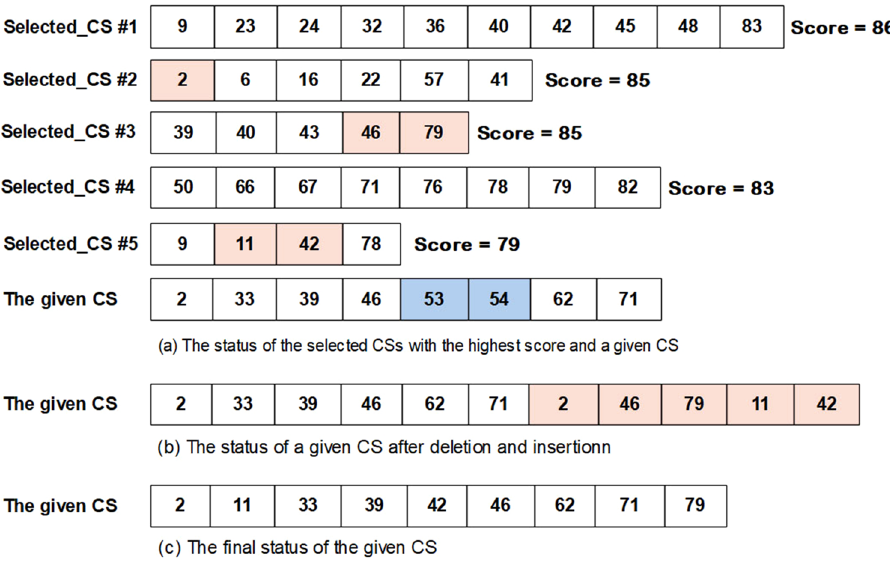
Figure 7. An instance of the transferring operator. The arrays present CSs which include a set of different features. ( a ) Five CSs with the highest scores are selected. The colored indices are the variables (features), which are imported to the given CS. The blue colors are the variables that are randomly selected and are removed from the given CS. ( b ) The status of the given CS is shown after deleting the blue highlighted features and inserting the pink highlighted features. ( c ) The finalized status of the given CS is presented. In this step, the selected features are sorted, and the repeated ones are removed. CS, candidate solution.